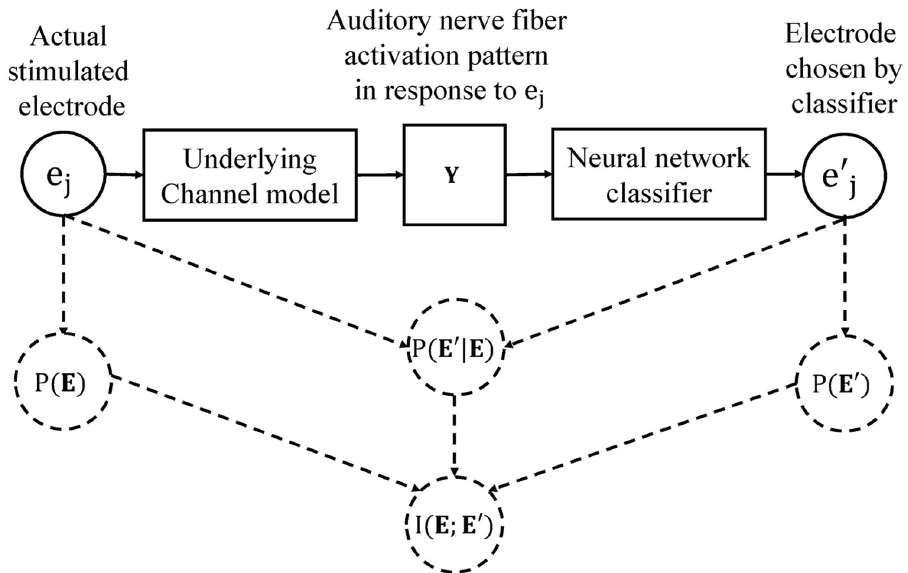
Fig 3. A full framework for estimating electrode discrimination ability. The probability of the system input, P E , and output, P E 0 , as well as the conditional probability, P E 0 | E , are estimated after the testing phase of the neural network classifier. Mutual information is then calculated using Eq (11).